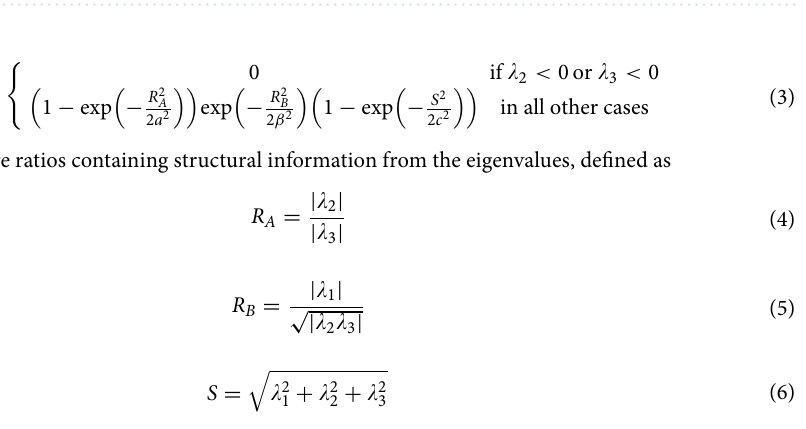
Figure 3. Algorithm Illustration. This image illustrates some of the algorithm steps on an SWI image. ( A) Initial SWI image, resampled. ( B) 2D gradient computation (gradient magnitude pictured). ( C) Edges of the slice as output after Canny edge detection. ( D) Initial potential ROIs labeled by the circular Hough transform. ( E) ROIs remaining after edge exclusion. ( F) ROIs remaining after circular grouping and size exclusion. ( G) Final ROI marked after CSF exclusion and multi-slice merging. ( H) Co-registered lobar map used to quantify distribution of detected